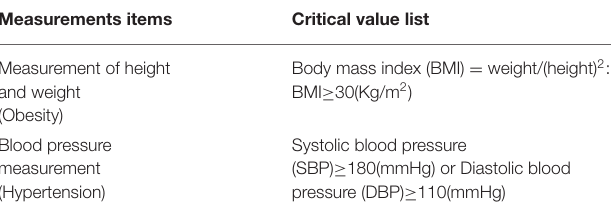
TABLE 4 | The critical value list in health checkup informed on